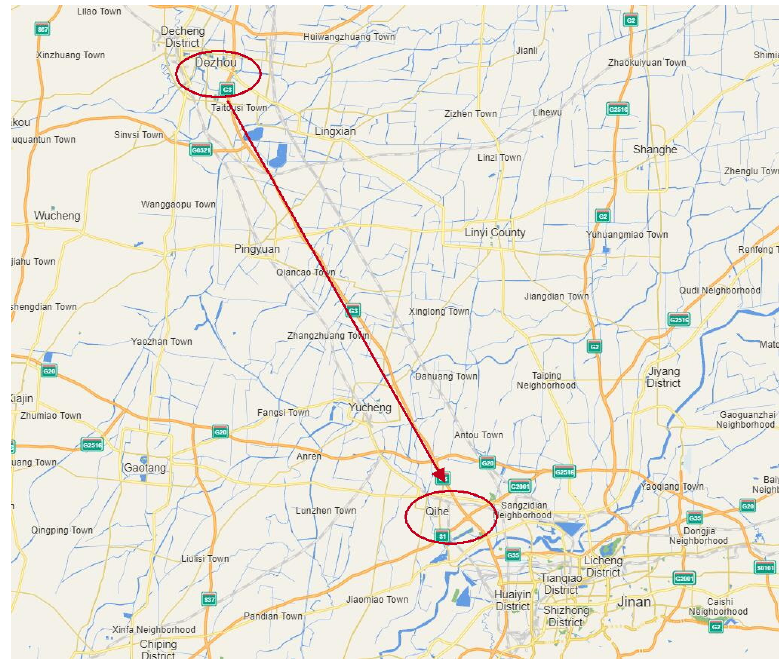
Figure 4. Geological location of the project.